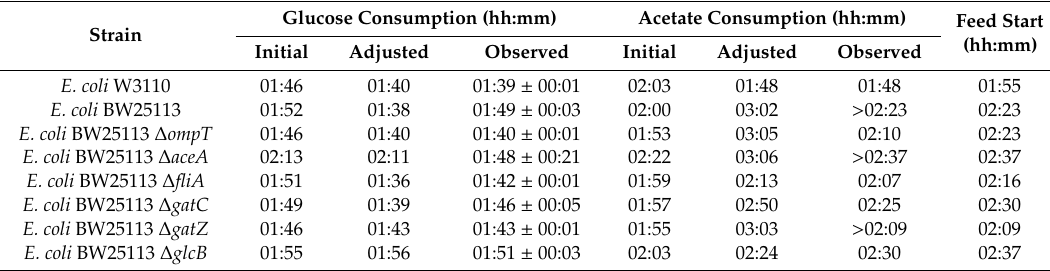
Figure 4. Illustration of the results of the model calibration cycles 1 to 3 for the cultures of E. coli BW25113 ∆ glcB . ( a ) Black dashed line: initial model without adjustment; blue line: current model calibration at time t n ; light blue line: previous model calibration (time t n − 1 ); grey crosses: measurements. ( b ) Computed feeding profiles after model calibration cycles 1 to 3 and the initial feed as a cumulative volume. Table 2. Batch end prediction overview: initial model, adjusted model (parameter estimation after 1.88 h) and observed times for consumption of glucose and acetate and the actual feed start based on the first executed glucose